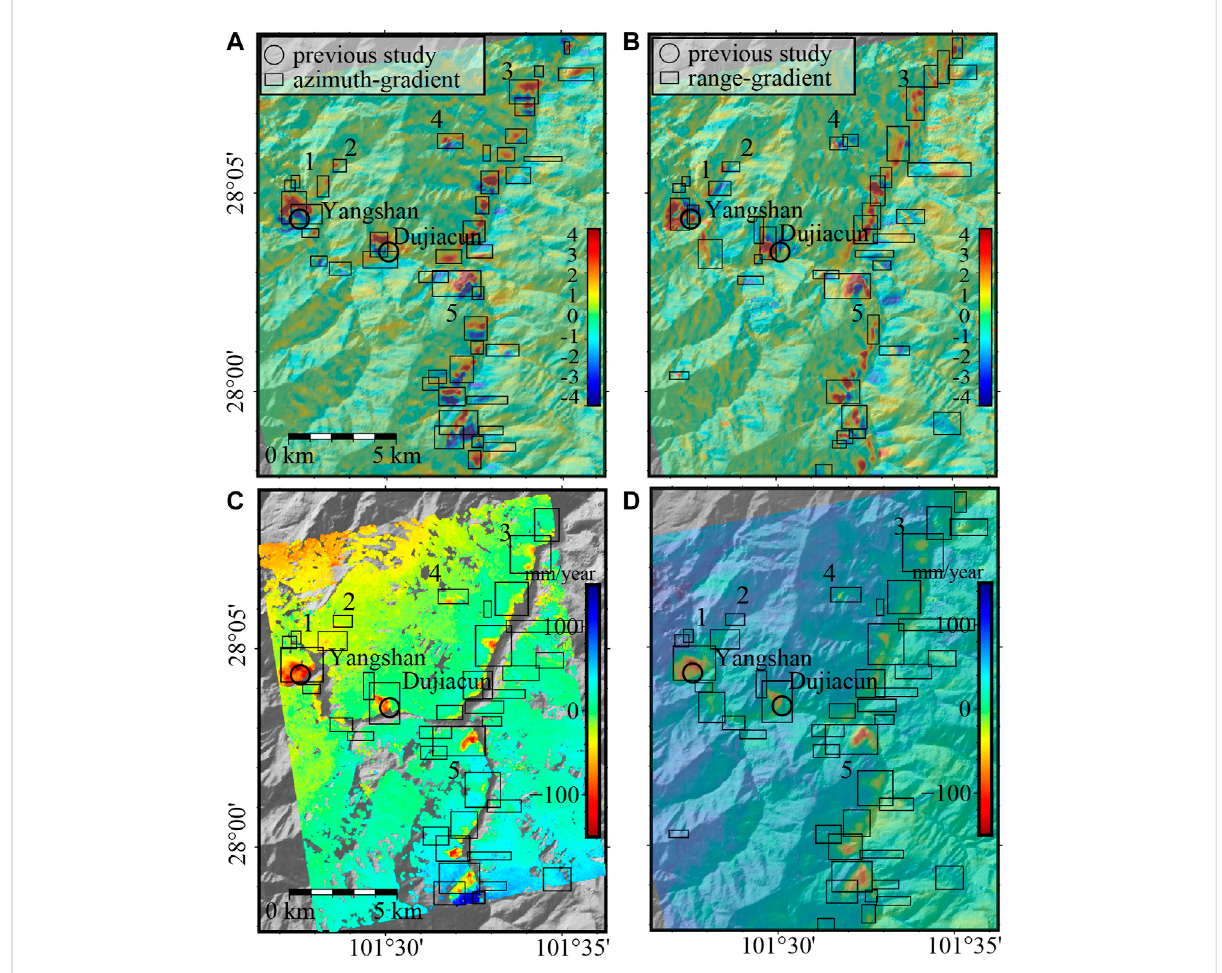
FIGURE 11 Slow-movinglandslidesinthemiddlesectionoftheYalongRiverdetectedbyAttention-YOLOv3inphase-gradientmapsalongazimuth (A) and range (B) directions.SurfacevelocitymapsderivedbytheSBAS-InSARmethod (C) andunwrapped-phasestacking (D) forthesamearea.Blackboxes aremergedresultsfrom (A,B) withnumbersindicatingaweaksignalintheInSARvelocitymaps.CirclesshowYangshanandDujiacunlandslidesfrom previous studies (Dai et al.,